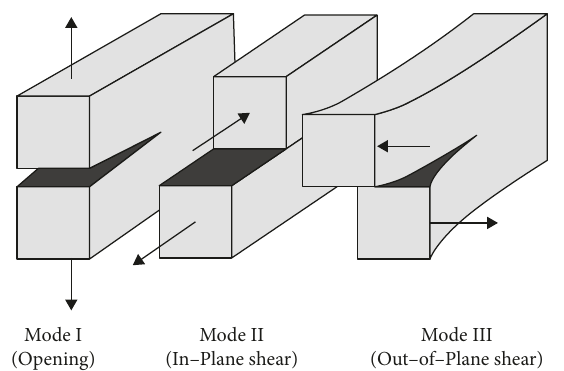
Figure 3: Calculation model of water-bearing jointed rock